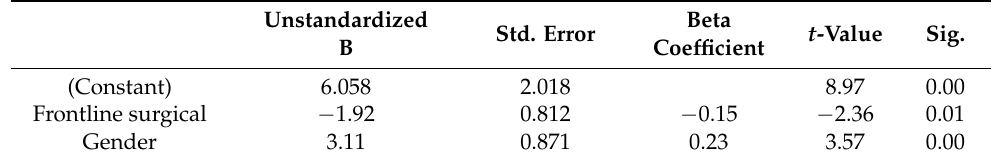
Table 6. Predictive model for GAD-7 scores.